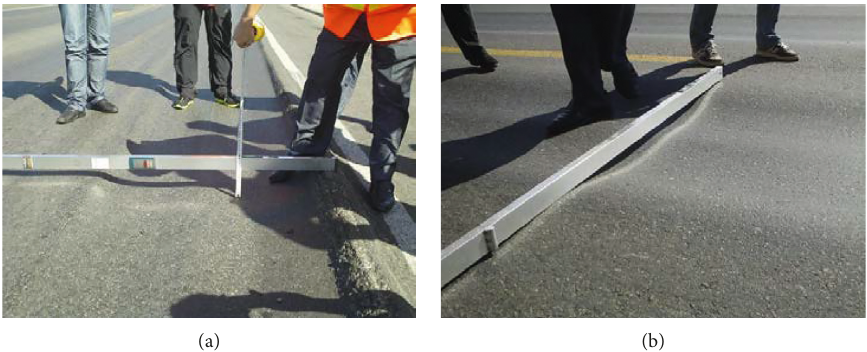
Figure 5: Rutting in southern Xinjiang: (a) no. 314 (Akesu-Kashgar Section); (b) no. 315 (Korla